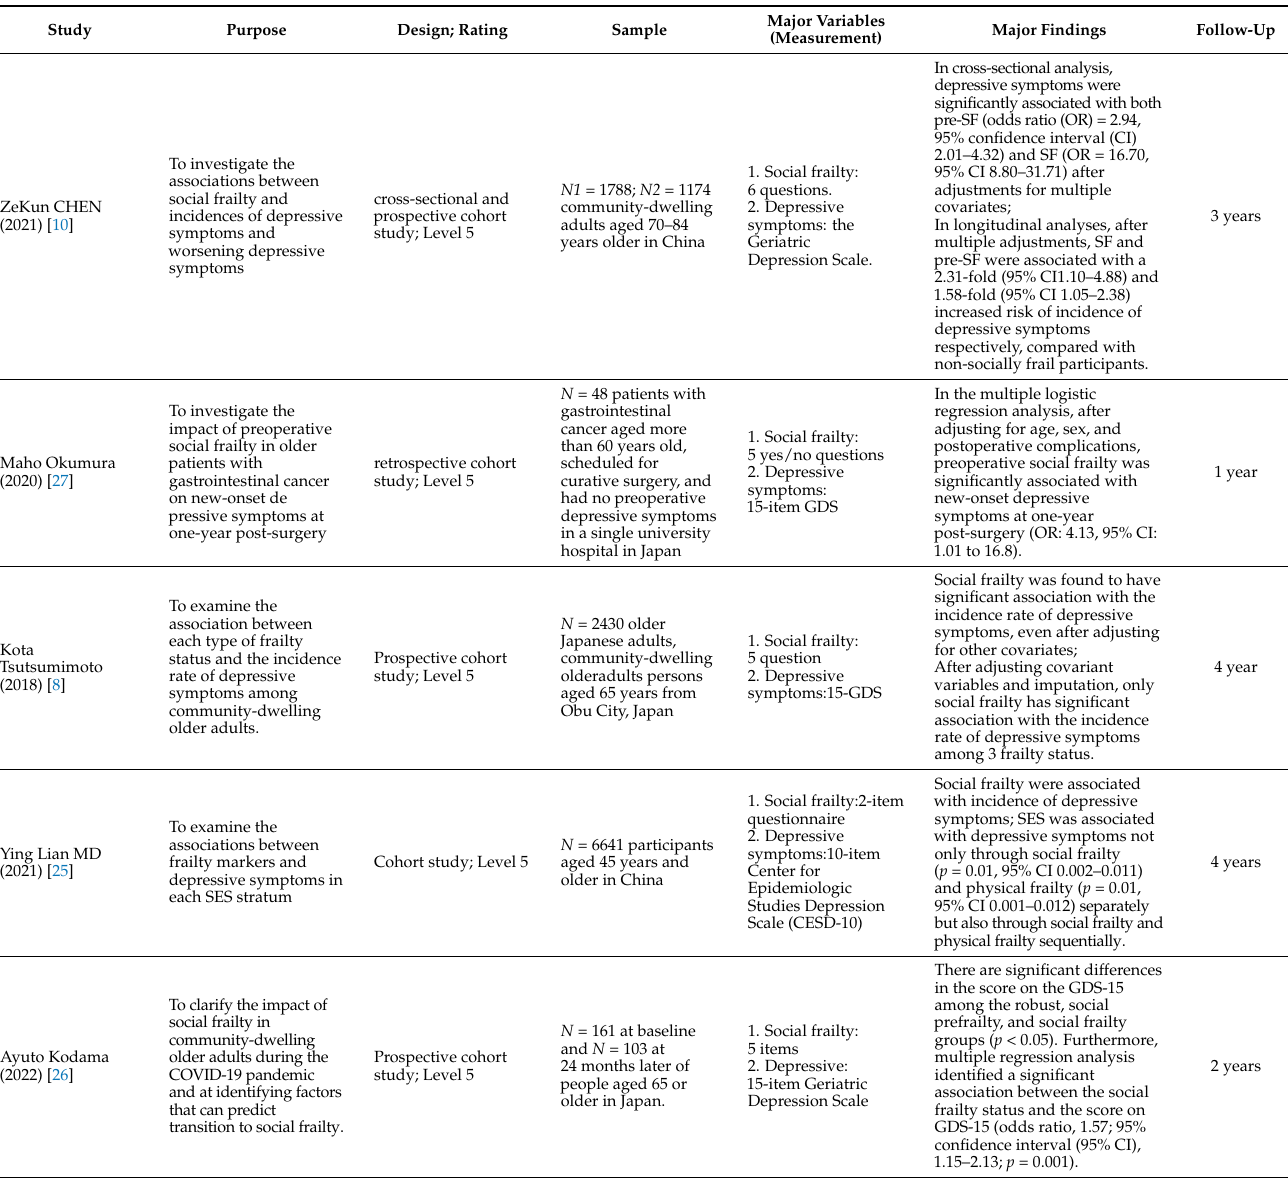
Table A1. Summary of data extraction from the cohort